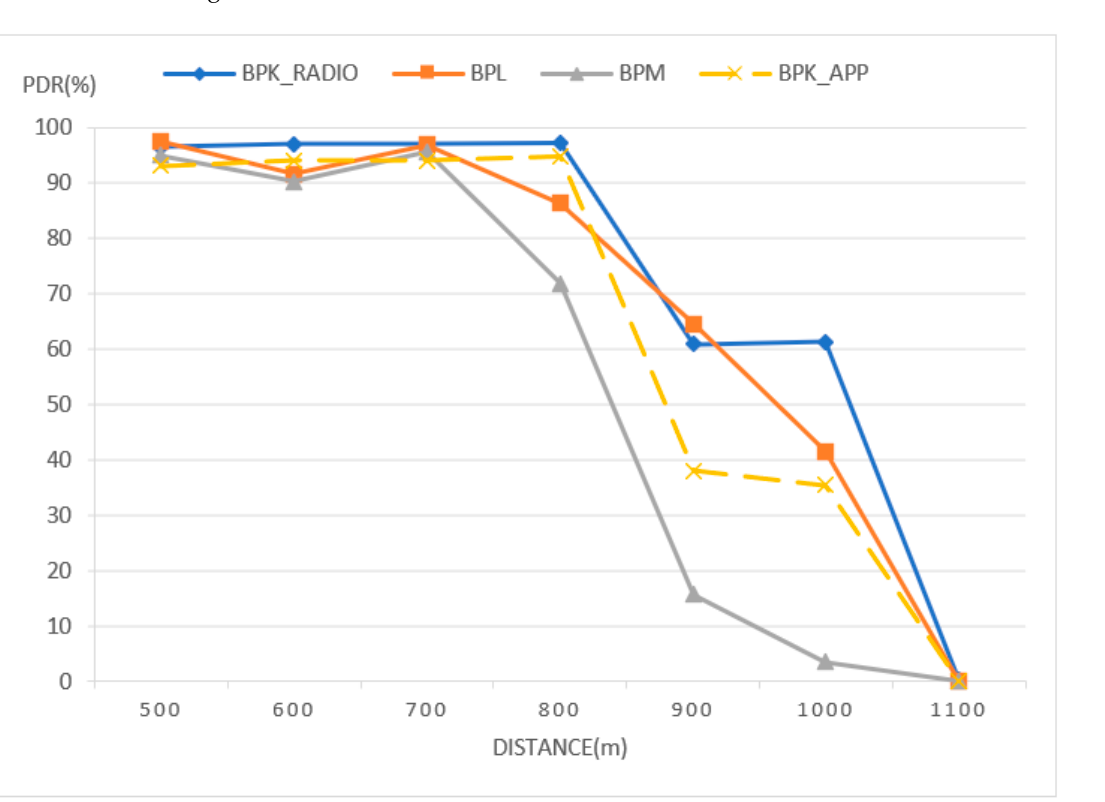
Figure 9. PDR(%) results in the static scenario (receiver placed at fixed distances).